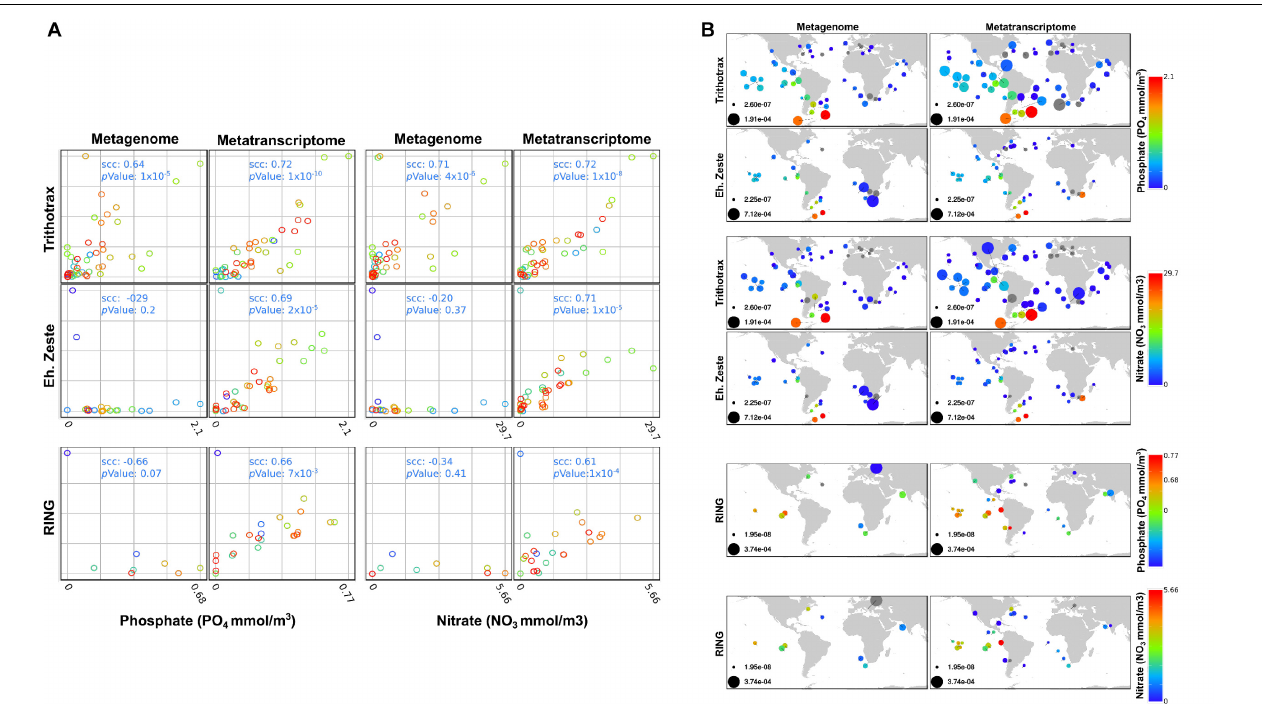
FIGURE 7 | Correlation analysis of Metagenome and metatranscriptome and distribution of PcG and TrxG in TARA stations. (A) Correlation of the relative levels of gene presence (Metagenome) and gene expression (Metatranscriptome) detected by TARA station for bacillariophyta sequences when compared with 3 different environmental levels. The relative levels correspond to the abundance in RPKM of each gene/complex at each station normalized by the total abundance in RPKM of bacillariophyta sequences detected at the same station, and then re-scaled to the unit interval (minimum and maximum levels are presented in figure B ). Abundances at each station were computed by pooling 4 size fractions, namely: 0.8 to 5, 5 to 20, 20 to 180 and 180 to 2000 µ m. Spearman correlations coefficients (scc) and p values represent statistical association of the environment levels of Phosphate, Nitrate and bioavailable Nitrogen with the relative levels of RING genes, Enhancer of zeste genes and the Trithorax complex. We note that correlations between each respective Metagenome and Metatranscriptome pair were not significant enough to be shown (scc < 0.22) and colors were used to distinguish different stations, for visual clarity. (B) Distribution of RING genes, Enhancer of zeste genes and the Trithorax complex among TARA stations. Disk sizes represent the relative levels of gene presence (Metagenome) and gene expression (Metatranscriptome) at each TARA station in RPKM. Color intensities shows the different environment levels of Phosphate, Nitrate and bioavailable Nitrogen according to the corresponding color bars, and gray disks represent relative levels of genes where environmental factors were not